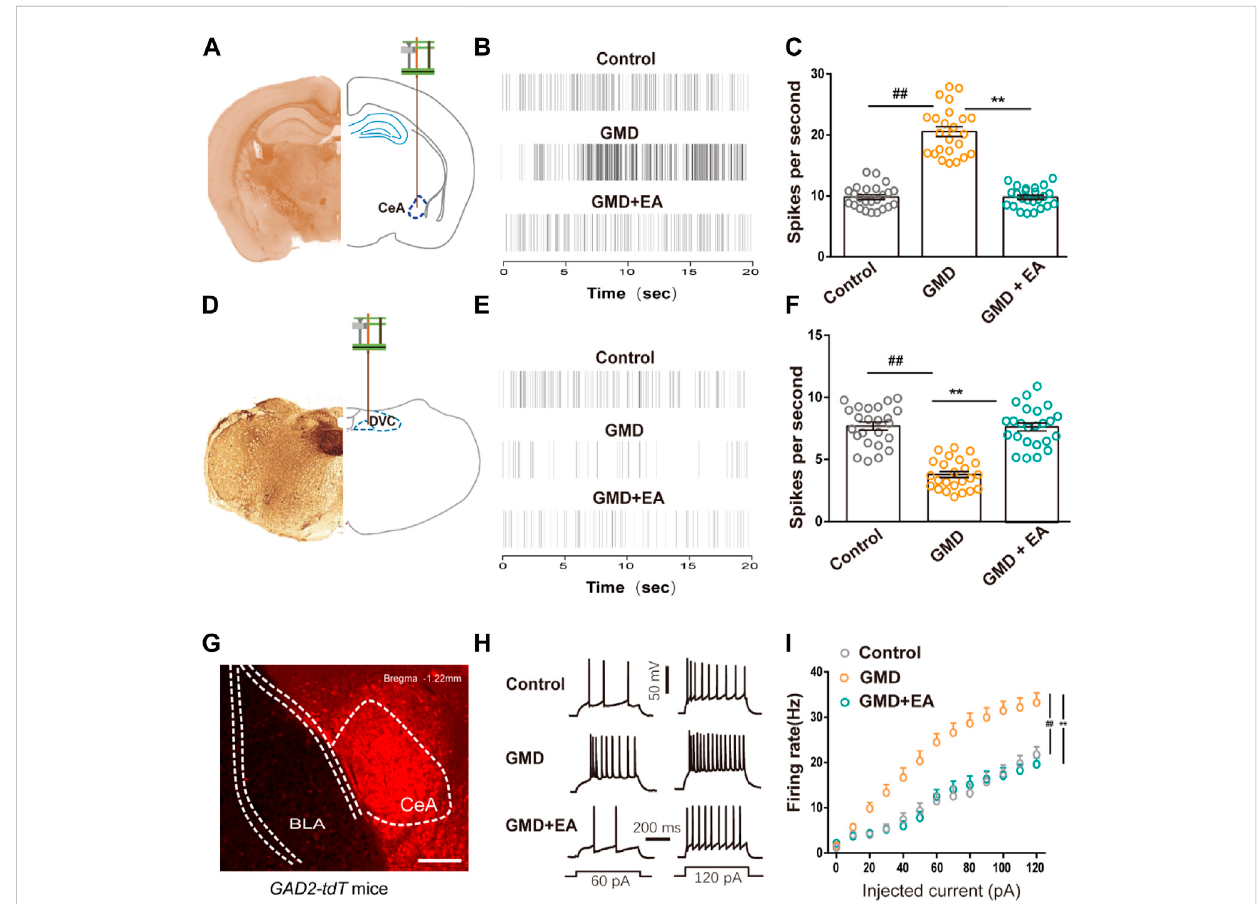
FIGURE 2 The effect of RS and EA on CeA and DVC neuronal activity (A, D) Schematic of in vivo electrophysiological recording of CeA and DVC neurons discharge. (B, C, E, F) Representativetraces (B, E) and summarized data (C, F) show the fi ring rate of CeA neurons and DVC neurons in mice with multiple channel recordings ( n = 24 units from six mice per group). (G) Representative image of GABA-tdTOM mice (GABAergic neurons with red tdTOM ). Scale bar, 100 µm. (H, I) Sample traces (H) and statistical data (I) for action potential fi rings recorded from GABAergic neurons in the CeA in mice ( n = 18 neurons from six mice per group). All of the data are presented as the mean ± SEM. ## p < 0.01, ** p < 0.01. One-way ANOVA for (C, F) ; two-way repeated-measures (RM) ANOVA for (I)